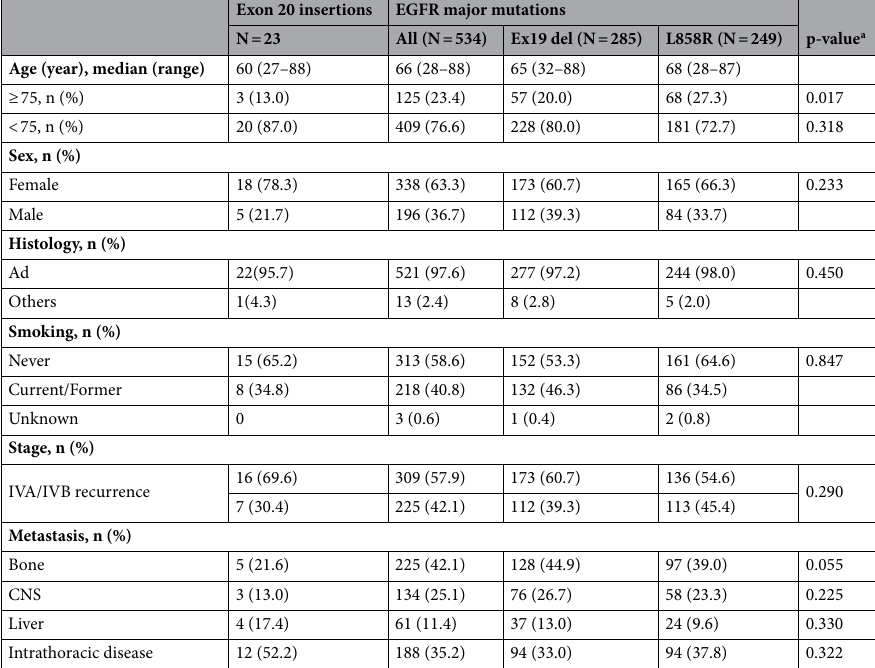
Table 1. Characteristics of patients harboring EGFR exon 20 insertions and major mutations at diagnosis. Ad Adenocarcinoma, CNS Central Nervous System. a Comparison of EGFR exon 20 insertions and major mutations.